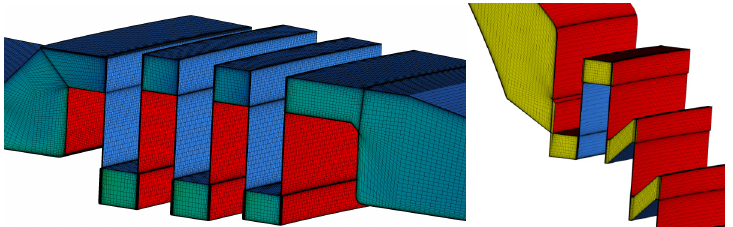
Figure 7. Hexahedral mesh of the upper and lower labyrinth seals of the model Francis turbine runner [8].